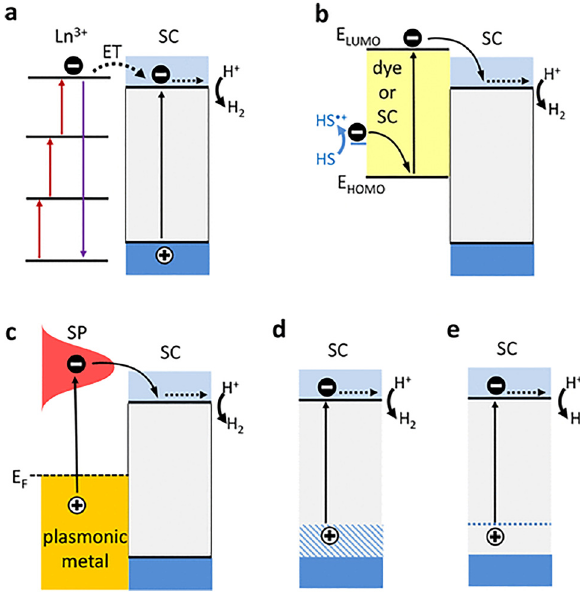
Figure 2: Extension of absorption range of a wide band gap semiconductor (SC) by various band gap engineering strategies, i.e., (a) energy transfer (ET) by upconverting rare-earth metals, e.g., Ln 3 + dopant (b) dye and other sensitization (c) sensitization through plasmonic material by electron transfer (d) orbitals hybridization by dopingwhichleadstoliftingof valencebandbyhighenergyorbitals (e) creation of the interband states by lattice defects. Adopted with permission from ref.